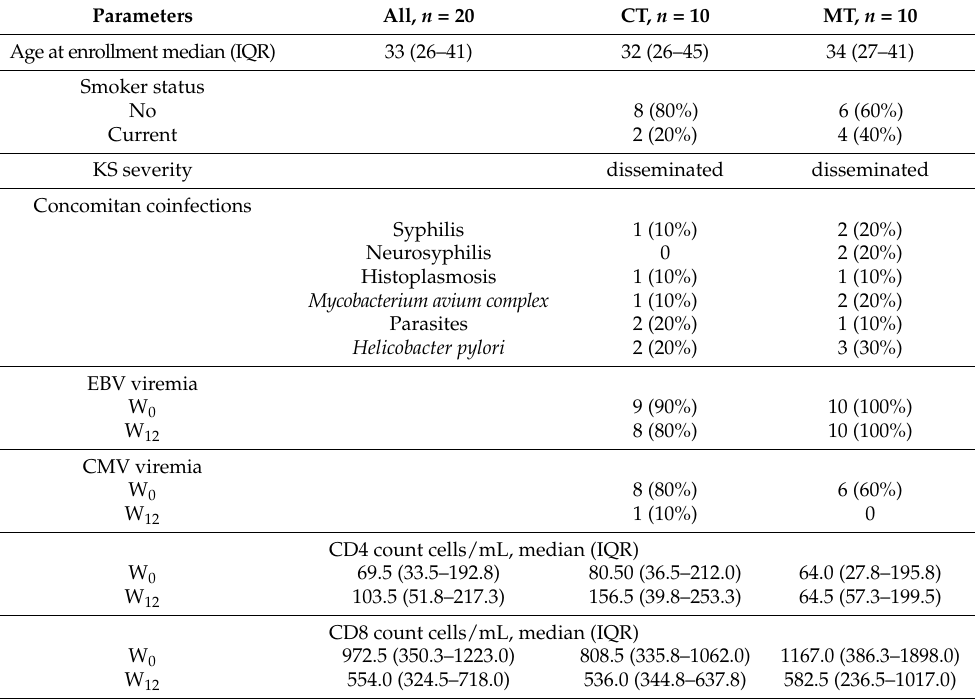
Table 1. Characteristics of KS/HIV patients.